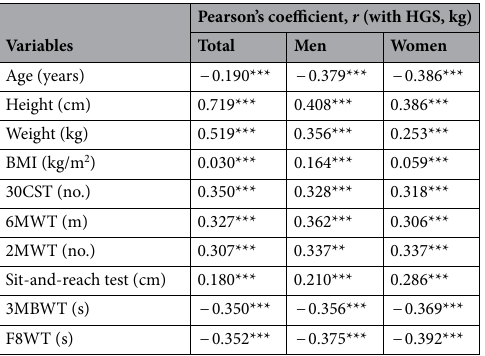
Table 2. Correlations between HGS and other physical fitness parameters. BMI body mass index, HGS hand grip strength, 30CST 30-s chair stand test, 6MWT 6-min walk test, 2MWT 2-min walk test, 3MBWT 3-m